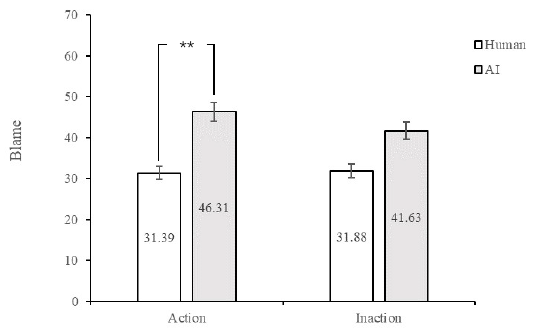
Figure 2. Rates of blame on human and AI agents. Note. ** p < 0.01.